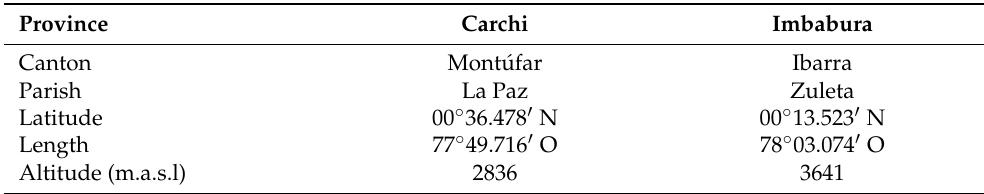
Table 1. Geographical description of the localities where the wild Andean blueberries ( V. floribundum Kunth) were collected.